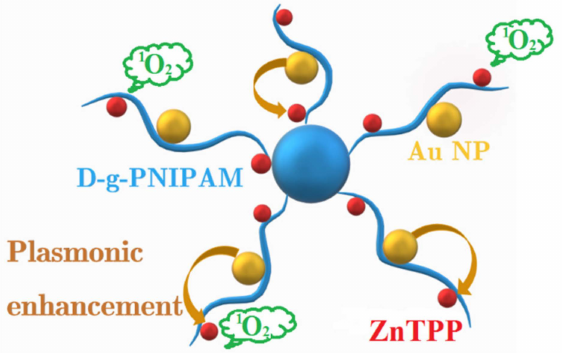
Figure 1. Scheme representing the structure of ZnTPP/D-g-PNIPAM/AuNPs hybrid macromolecule as well as the plasmon enhancement of singlet oxygen